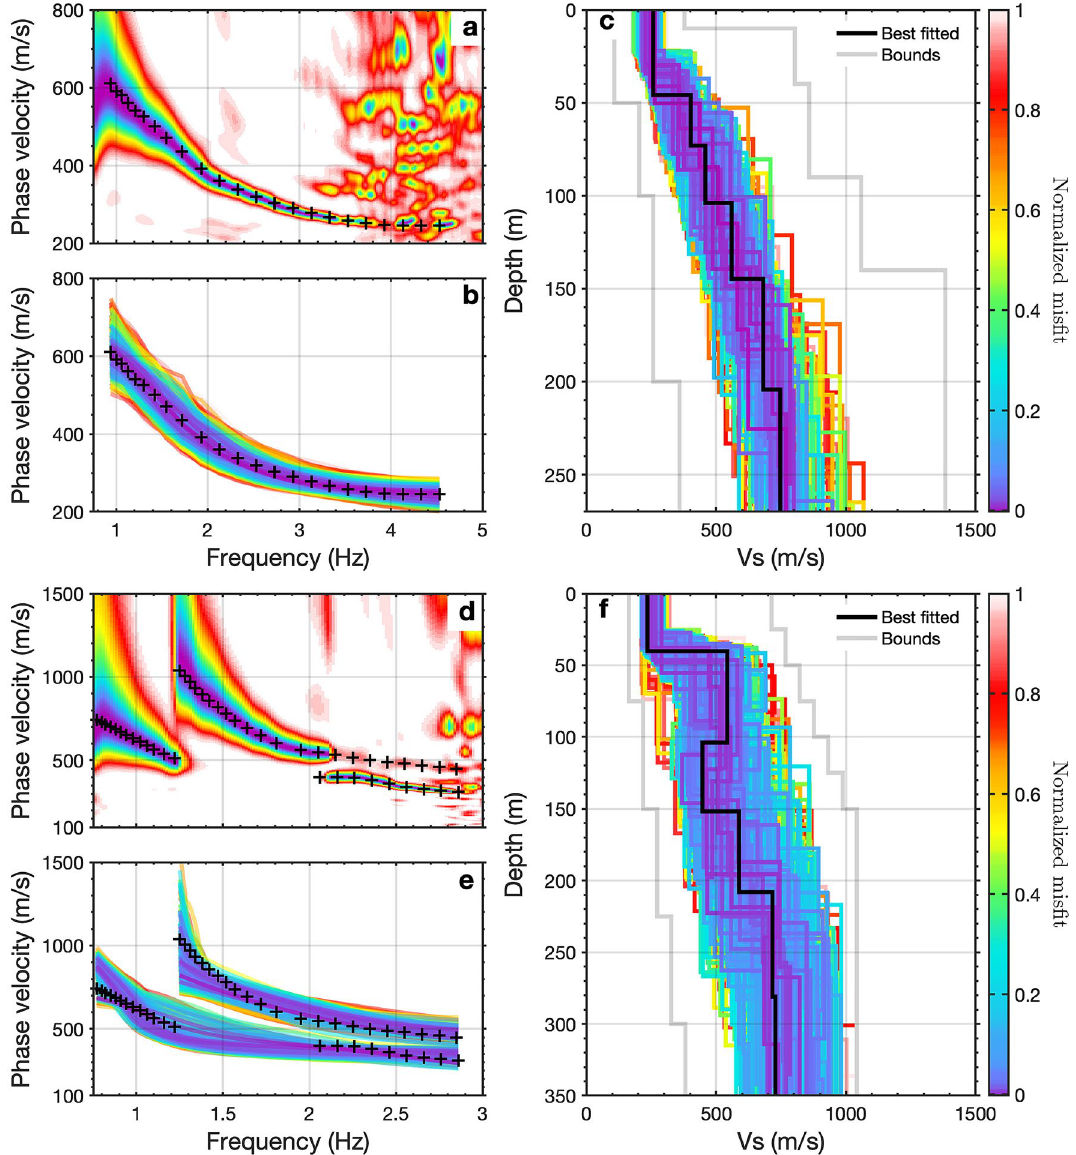
Figure 5. Examples of Scholte wave dispersion measurements and inversion. ( a ) Measured dispersion measurement and the picked dispersion curve with virtual source located at 6 km location; ( b ) presents the accepted forward modeled dispersion curves that fit measured dispersion curves well; ( c ) presents the accepted inverted V s models with the best fit model indicated by the solid line. ( d – f ) present the similar dispersion measurement with overtones and inversion with virtual source located at 17 km